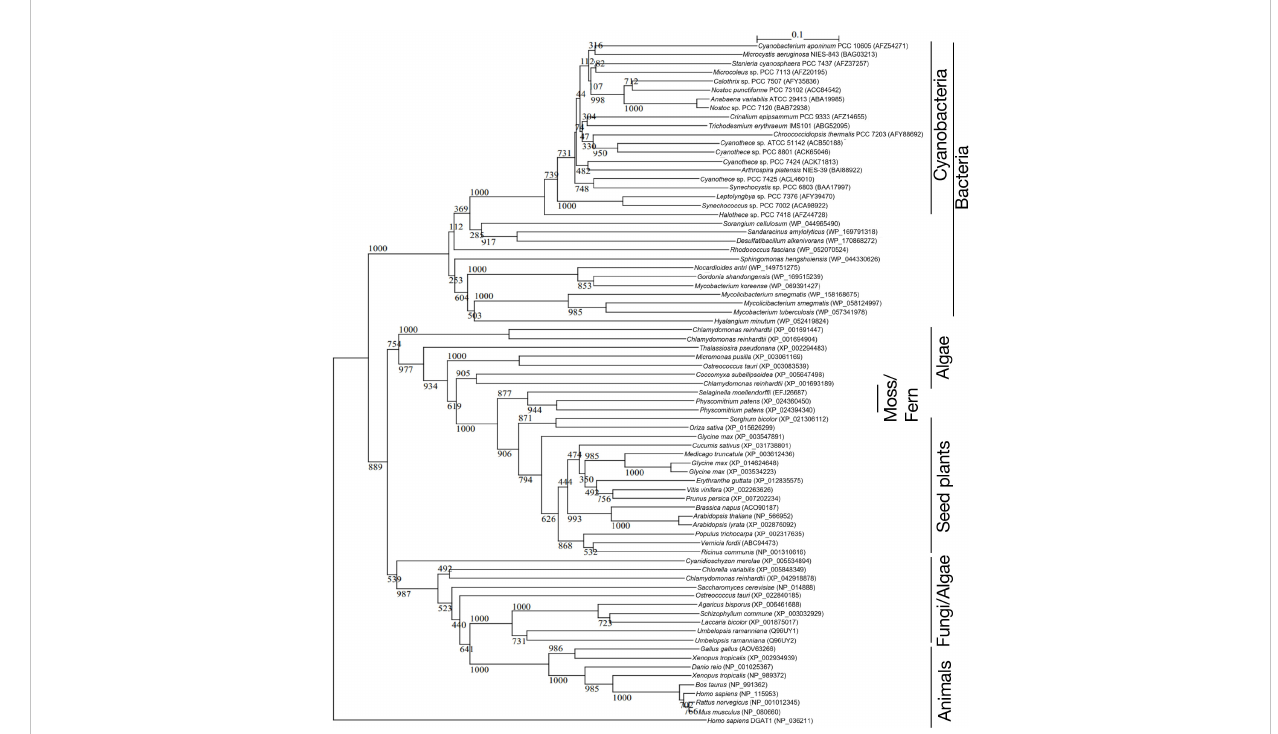
FIGURE 3 Phylogenetic tree of DGAT2 homologs. The tree was constructed with the use of sequence alignment of the DGAT2-homolog sequences shown in Table S3. Numbers at the branches: Bayesian posterior probabilities. The numbers after taxa: accession